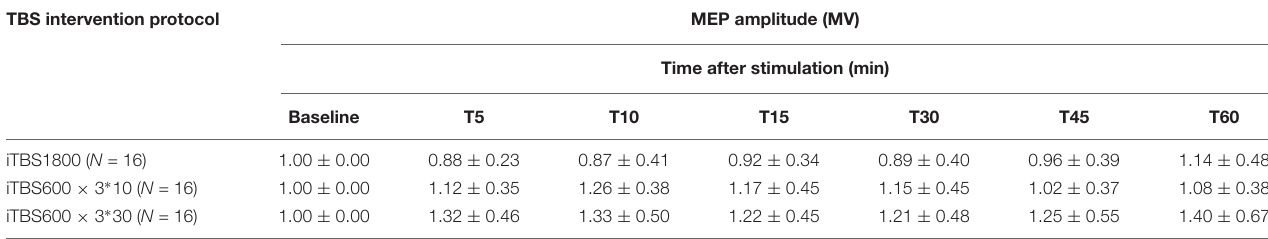
TABLE 3 | Normalized MEP amplitude for baseline and post stimulation measurement.